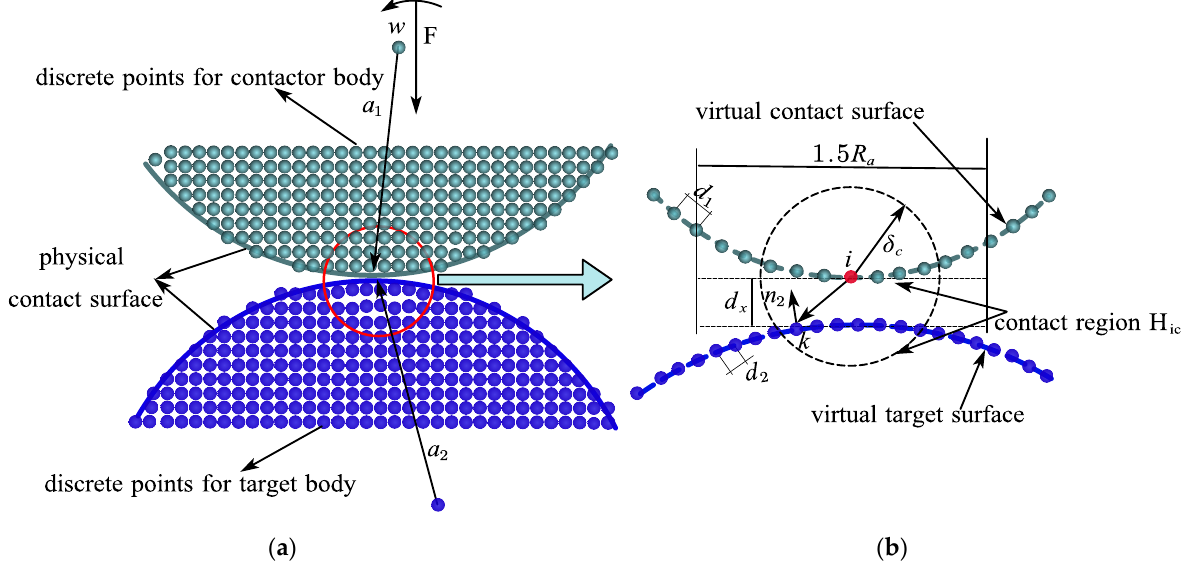
Figure 3. ( a ) Physical contact faces between two surfaces. ( b ) Peridynamic virtual contact surface and target surface.